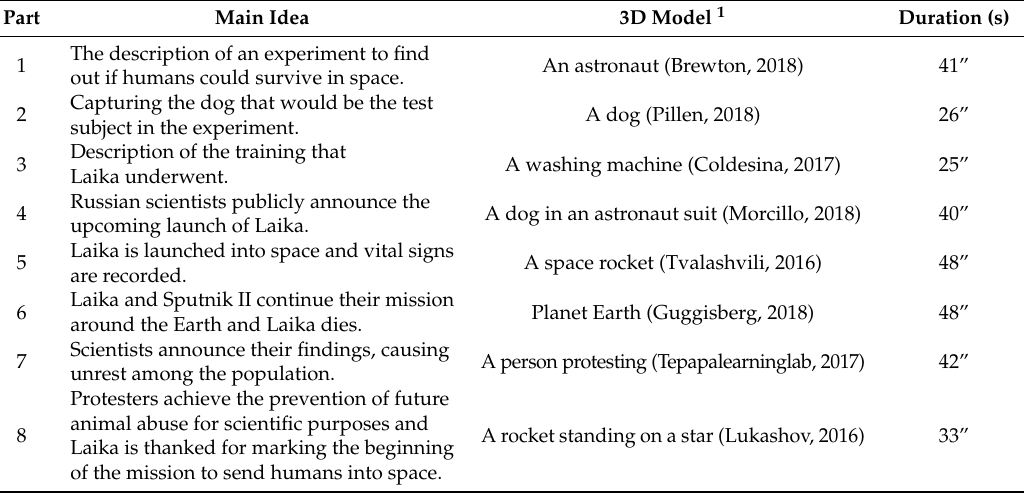
Table 2. Summary of the parts of the augmented reality audio